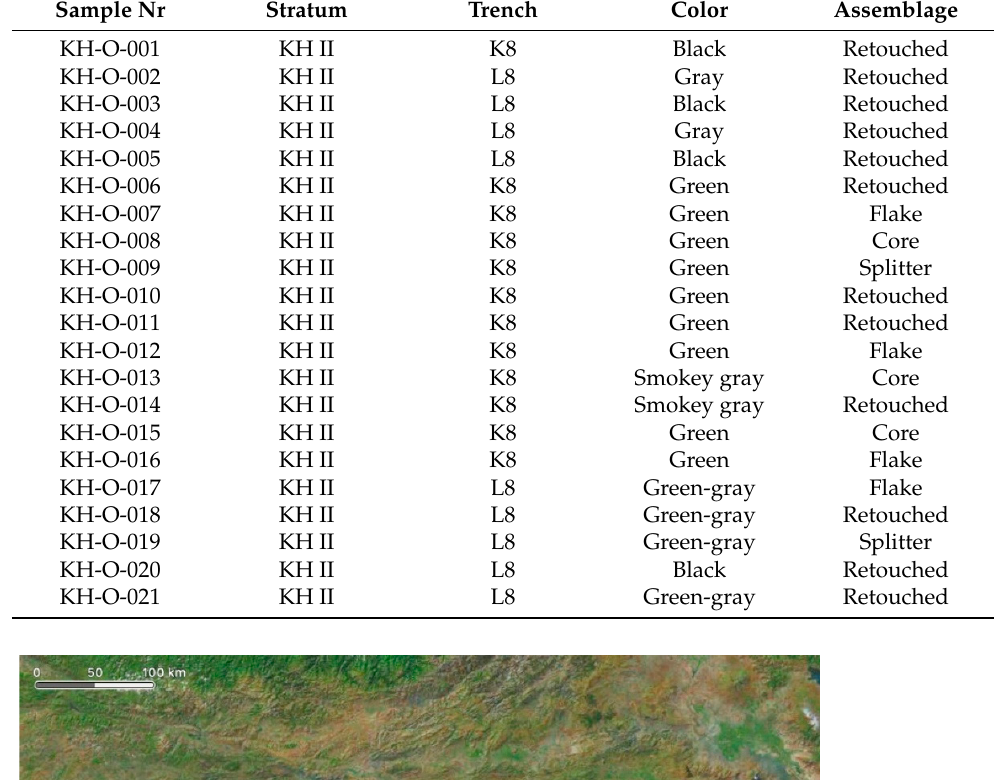
Table 2. Contextual and technological information for the analyzed Kendale Hecala II artefacts dated to cal. 5600–5000 B.C.